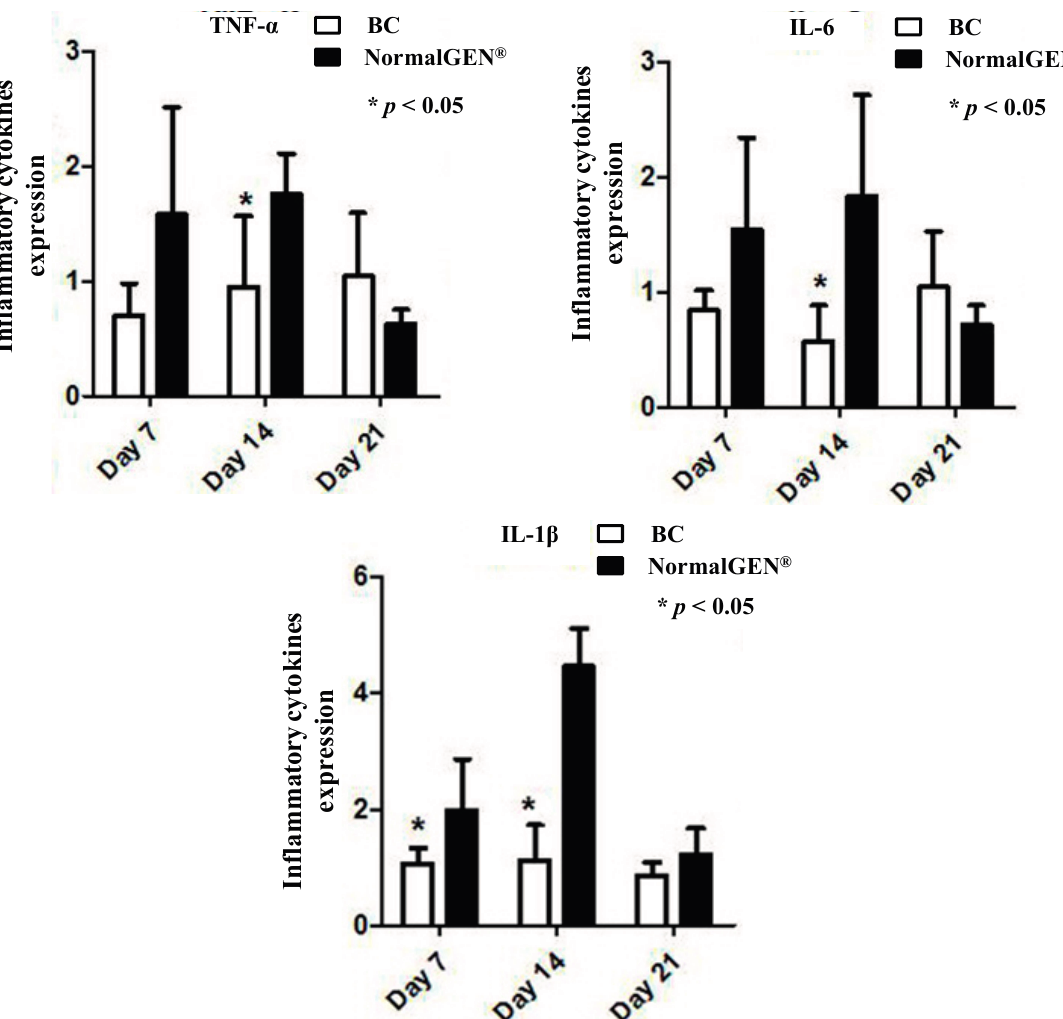
Figure 4. Effect of inflammatory cytokines on gene expression after implantation. Dural defects of rabbits were repaired by BC and NormalGEN ® on each side. After 7, 14 and 21 days, real-time PCR analysis was performed for gene mRNA expression normalized by glyceraldehyde-3-phosphate dehydrogenase (GAPDH). Data are expressed as mean ± SD (standard deviation). * p < 0.05, vs . control ( n = 5).